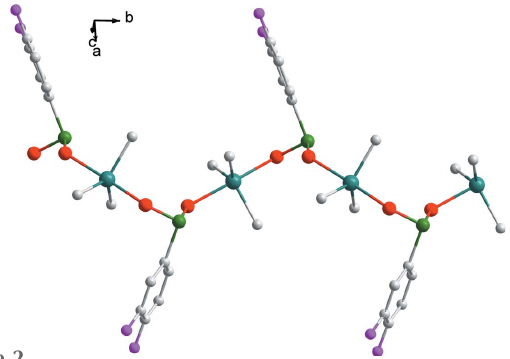
Figure 2 View of the polymeric chain structure in the title compound running parallel to [010]. H atoms have been omitted for clarity.